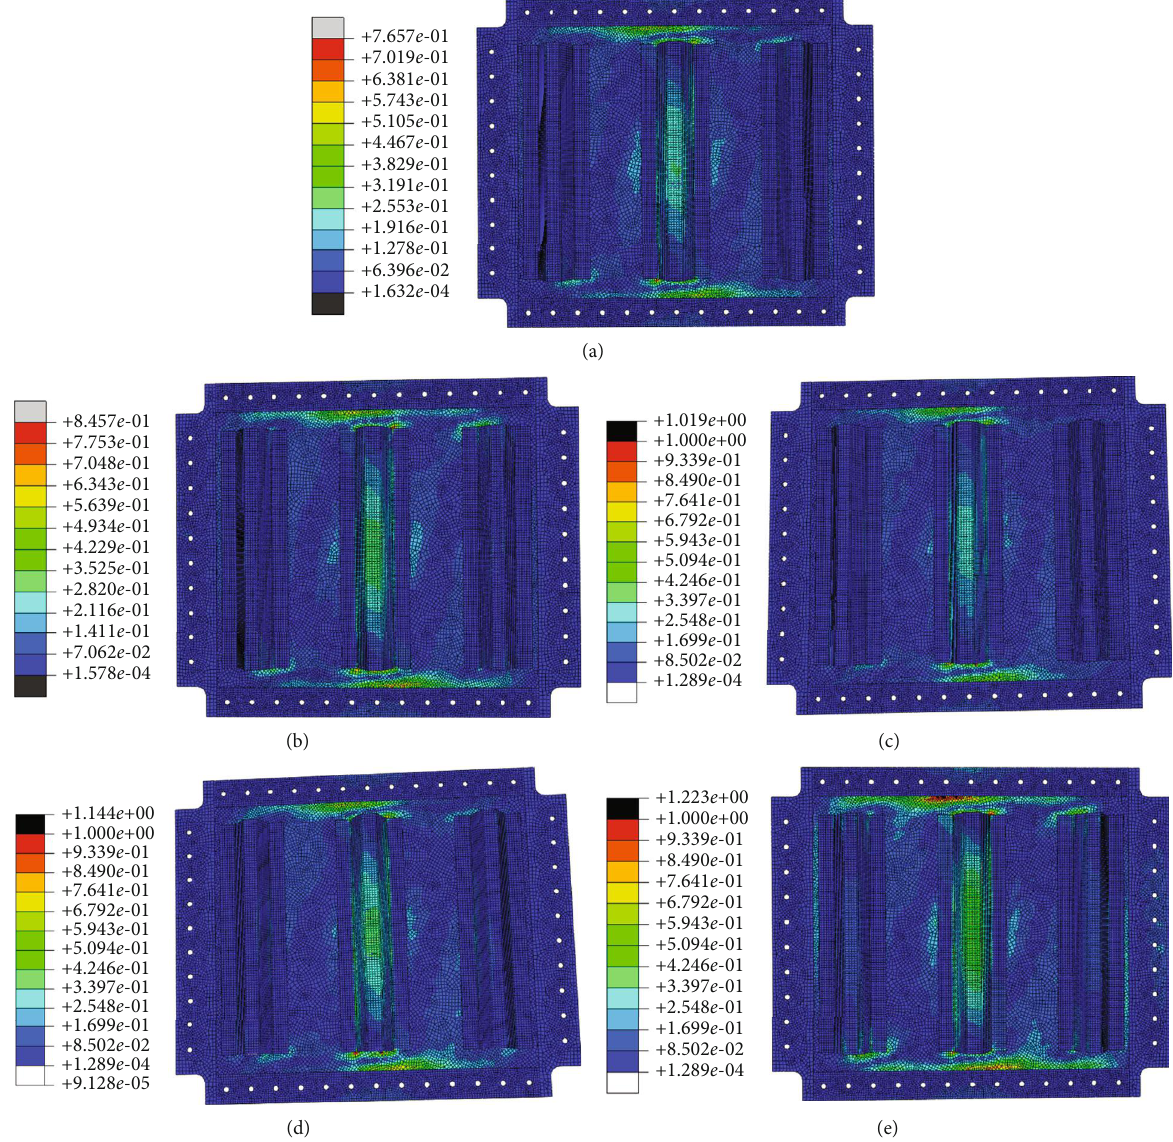
Figure 29: Tsai-Wu failure coe ffi cient of the composite-reinforced wall panels. (a) 60mph, (b) 70 mph, (c) 80 mph, (d) 90 mph, and (e)